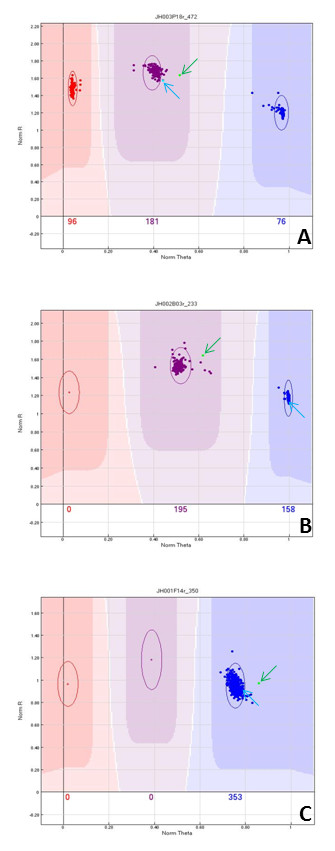
Genome Studio outputs of Manhattan distance graphs of three different SNPs assayed with the 6 K walnut SNP Infinium assay. A shows both parents, ‘Chandler’ (green dot indicated by green arrow) and ‘Idaho’ (light blue dot indicated by blue arrow), heterozygous at a locus. F1 progeny segregation (96:181:76) approximates the 1:2:1 monohybrid segregation ratio of two codominant alleles. B shows ‘Chandler’ heterozygous and ‘Idaho’ homozygous at a locus. F1 progeny segregation (195:158) approximates the 1:1 monohybrid back-cross segregation ratio. C shows both parents monomorphic at the locus and no segregation (353:0) of F1 progeny.